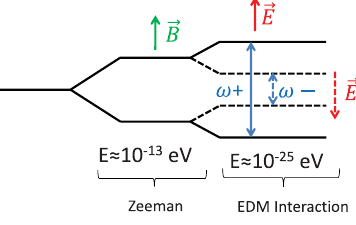
Figure 2. Level scheme 129